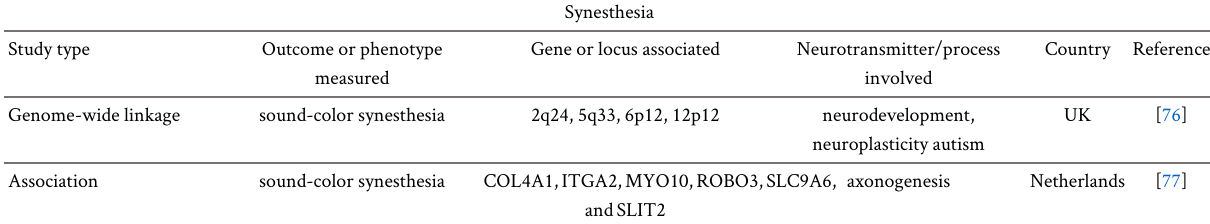
Table 3. Summary of published studies examining the genetic background of